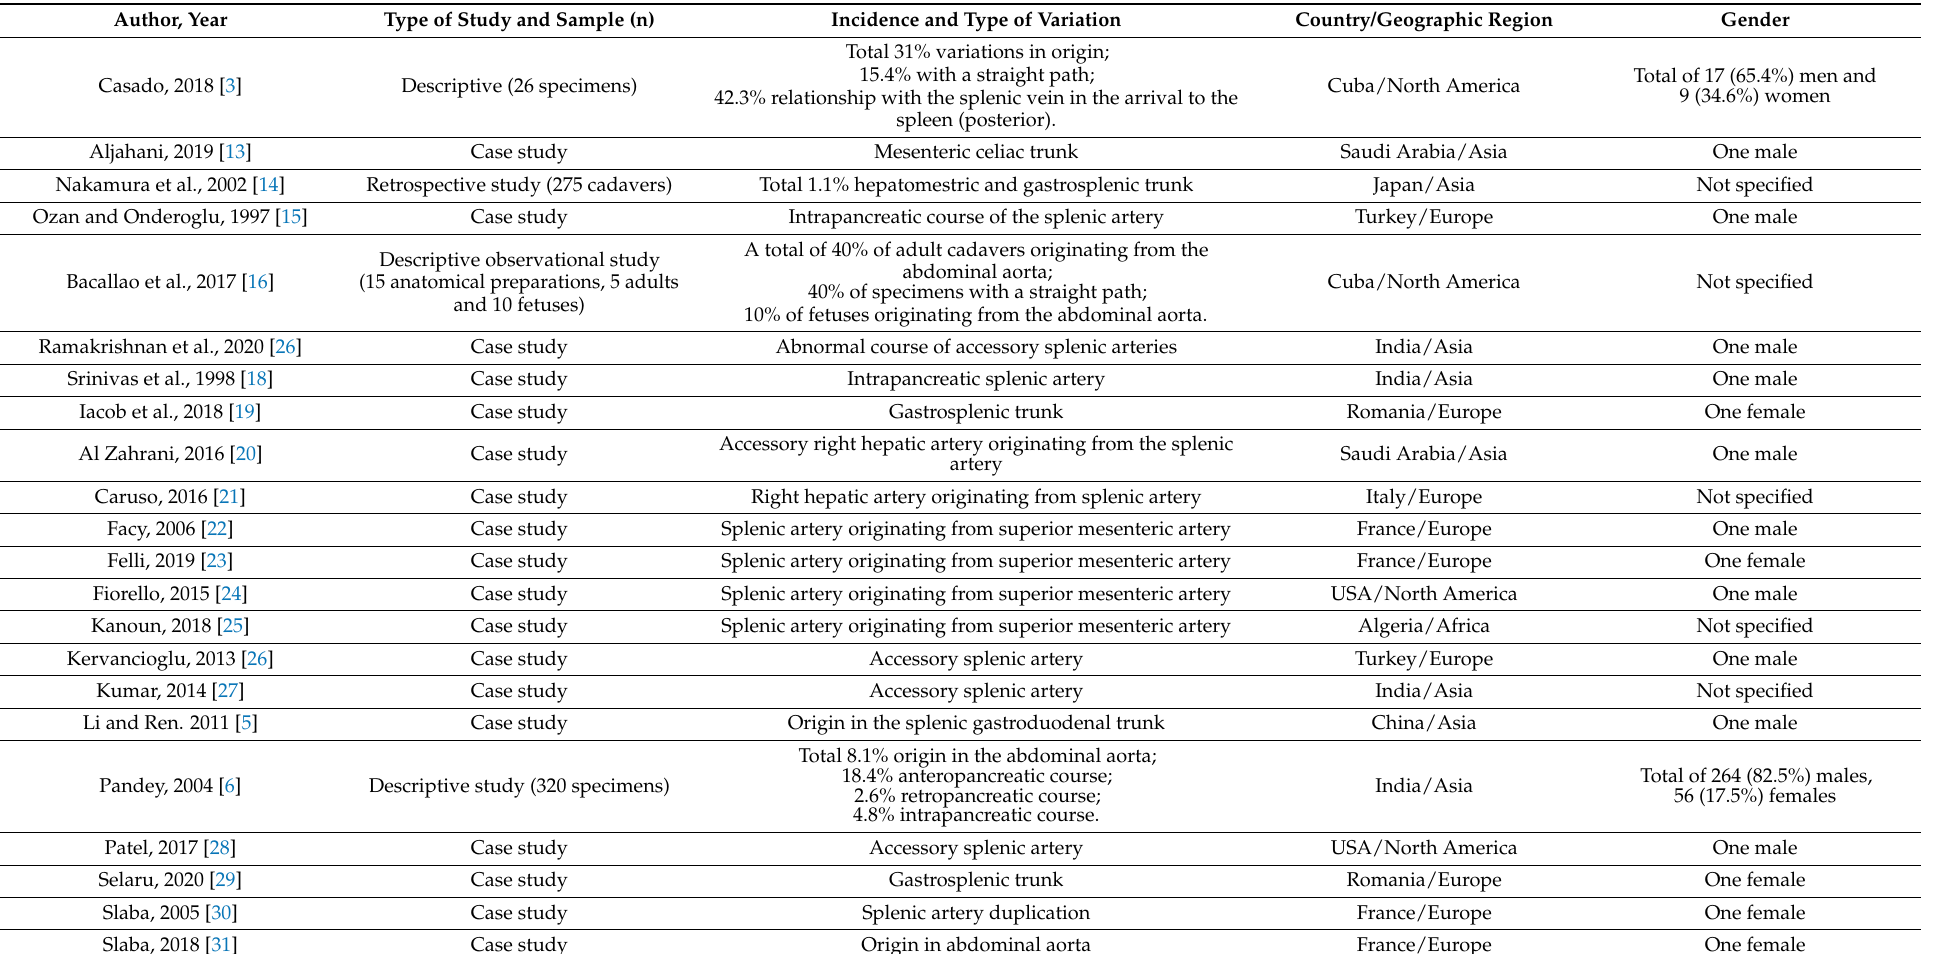
Table 3. Summary of articles included in the